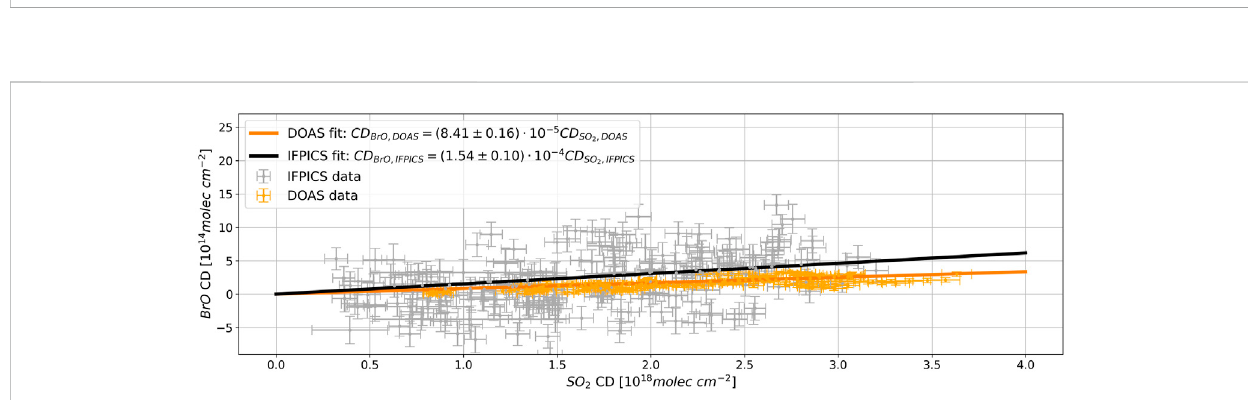
FIGURE 11 BrO/SO 2 ratio calculated from both instruments for the time period between 07:38 and 08:24 UTC. The pixels compared correspond to the FOV of the in fi eld DOAS. The orange points show the in fi eld DOAS measurement fi tted with a linear function (solid orange line). The grey points mark the IFPICS measurement evaluated in the in fi eld DOAS FOV also fi tted with a linear function (black solid line).